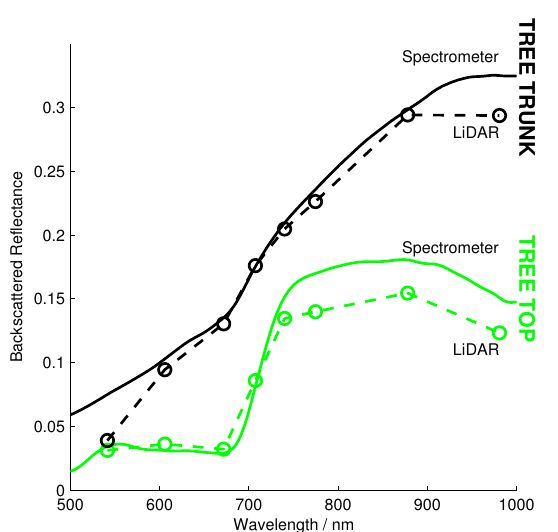
Fig. 4. Passive spectrometer measurement (solid line) and hyperspectral LiDAR (dashed line) of same areas of the tree are shown.